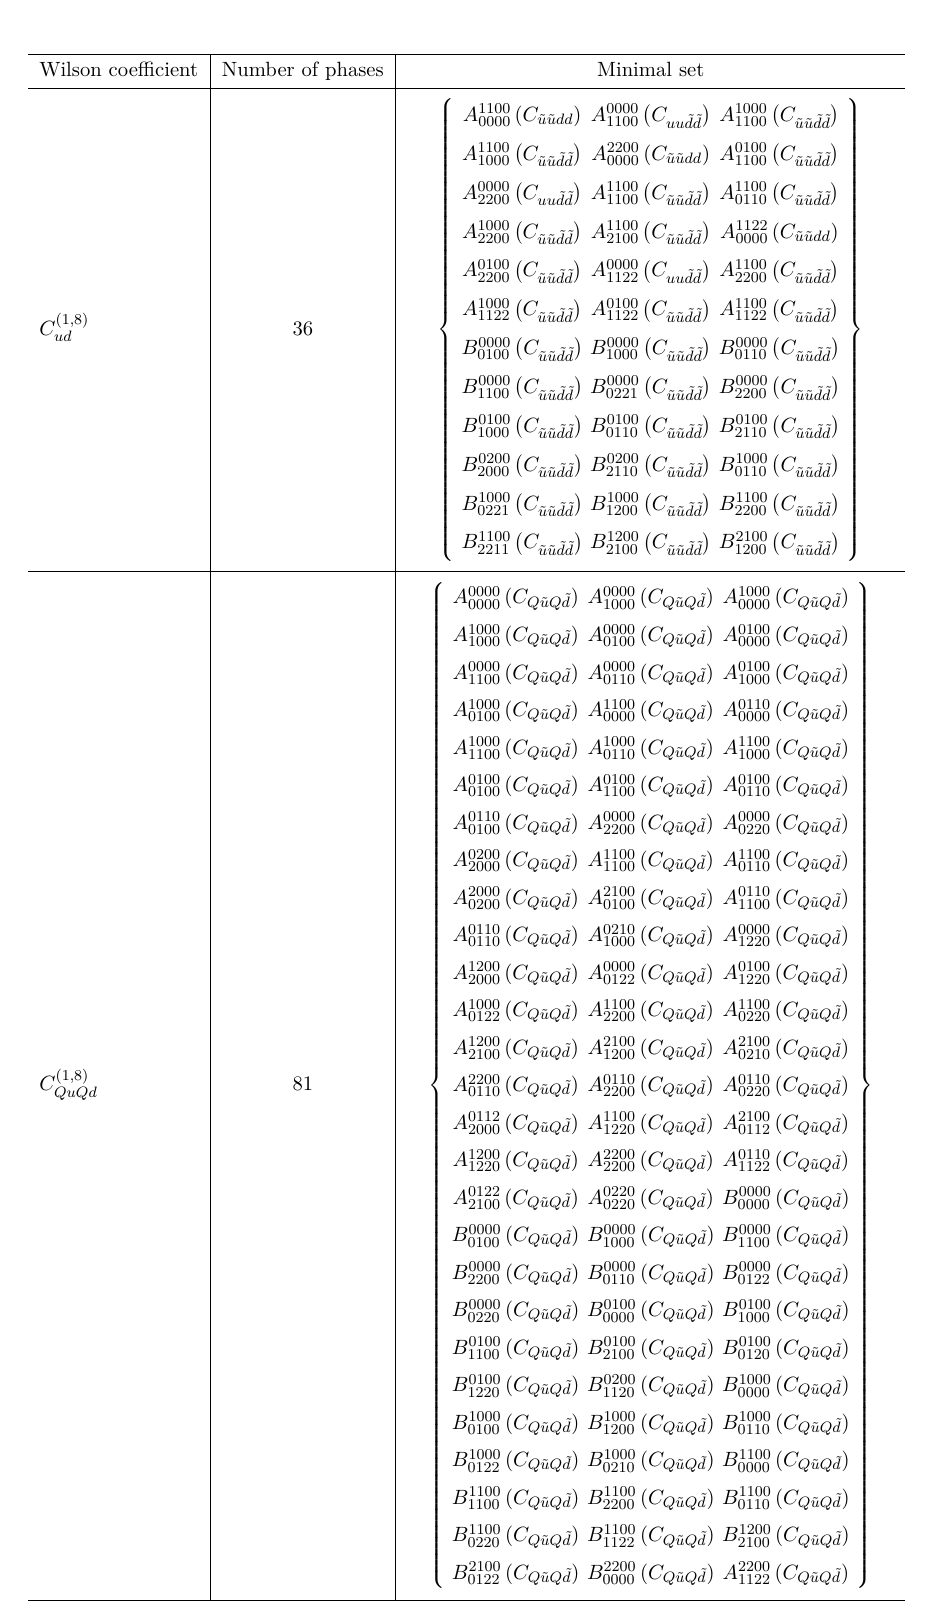
Table 13 . Continuation of tables 11 and